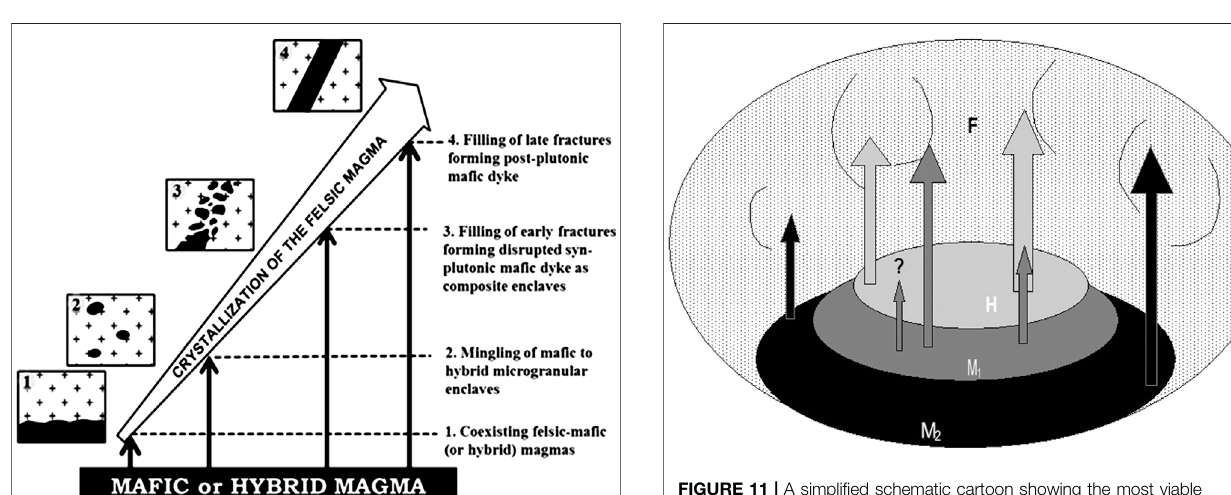
FIGURE 11 | A simpli fi ed schematic cartoon showing the most viable genetic model of ma fi c to hybrid and composite enclaves in granites. Ma fi c magma (M 1 ) pooled below and mixed with the partly crystalline felsic magma chamber to form hybrid magma (H) zone. Both the ma fi c and felsic magmas were crystal charged. Another pulse of ma fi c magma (M 2 ) accumulated below the M1. The ma fi c to hybrid magmas were injected into the overlying felsic magma chamber during its initial to waning stages of crystallization and formed the various enclave types observed in the studied granites of Ladakh Batholith (Based on Kumar, 2010a, and references therein). Post plutonic dyke intrudes after the consolidation of granite